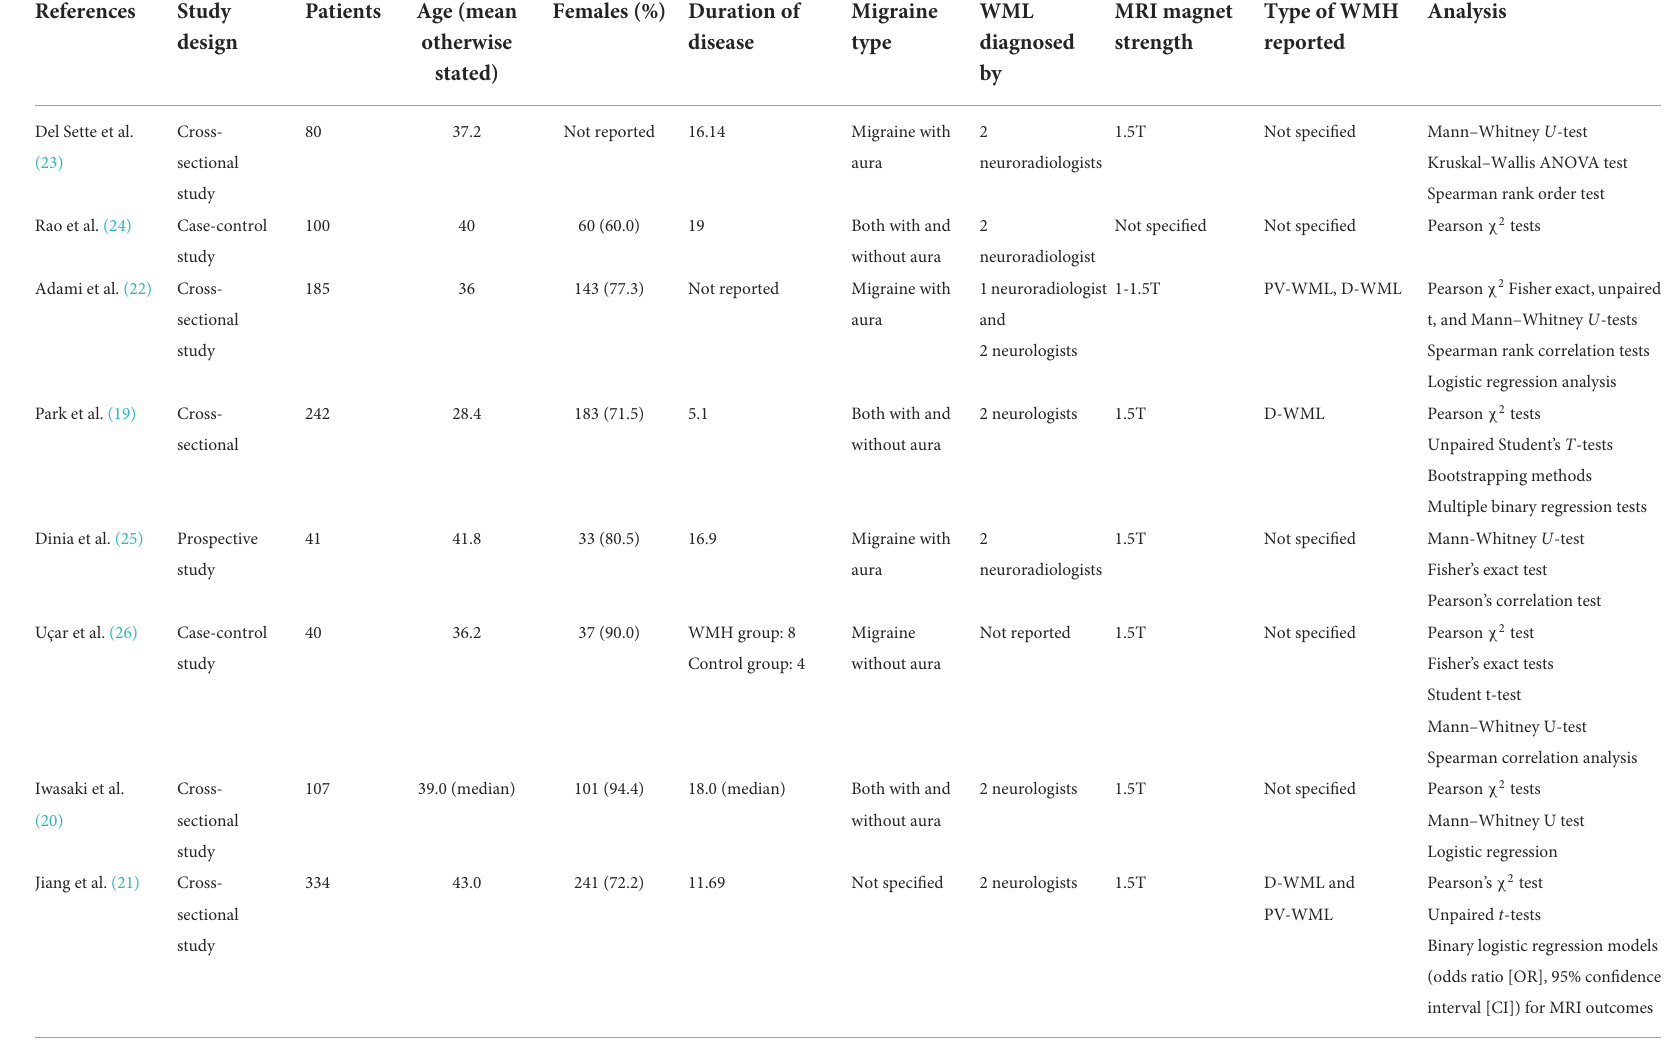
TABLE 2 Characteristics of included